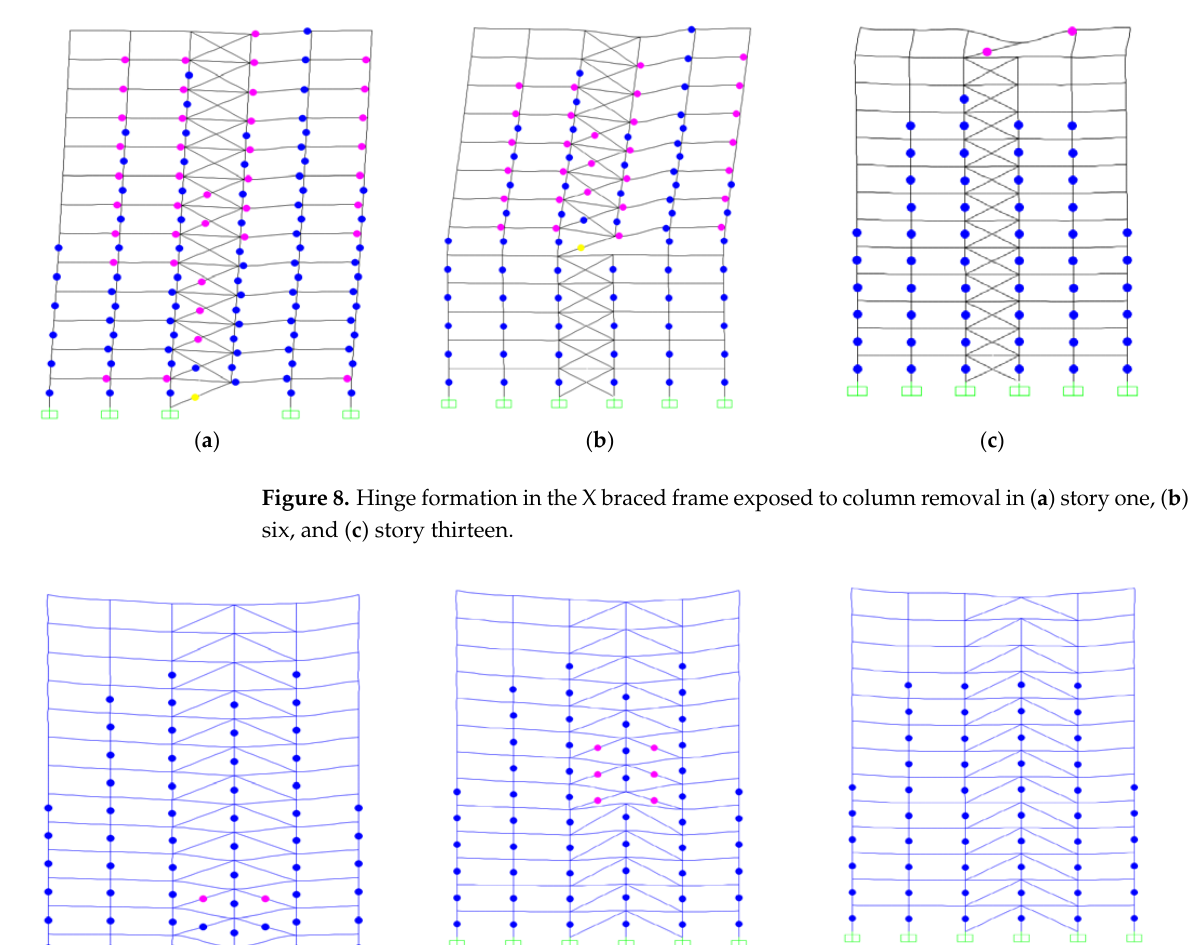
Figure 7. Hinge formation in the moment-resisting frame (Bare frame) exposed to column removal in ( a ) story one, ( b ) story six, and ( c ) story thirteen.